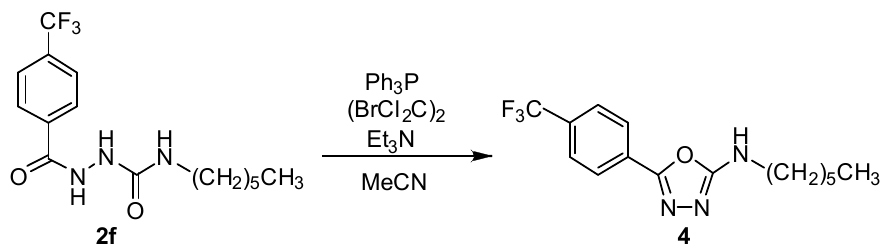
Table 1. IC 50 values for AChE and BuChE.